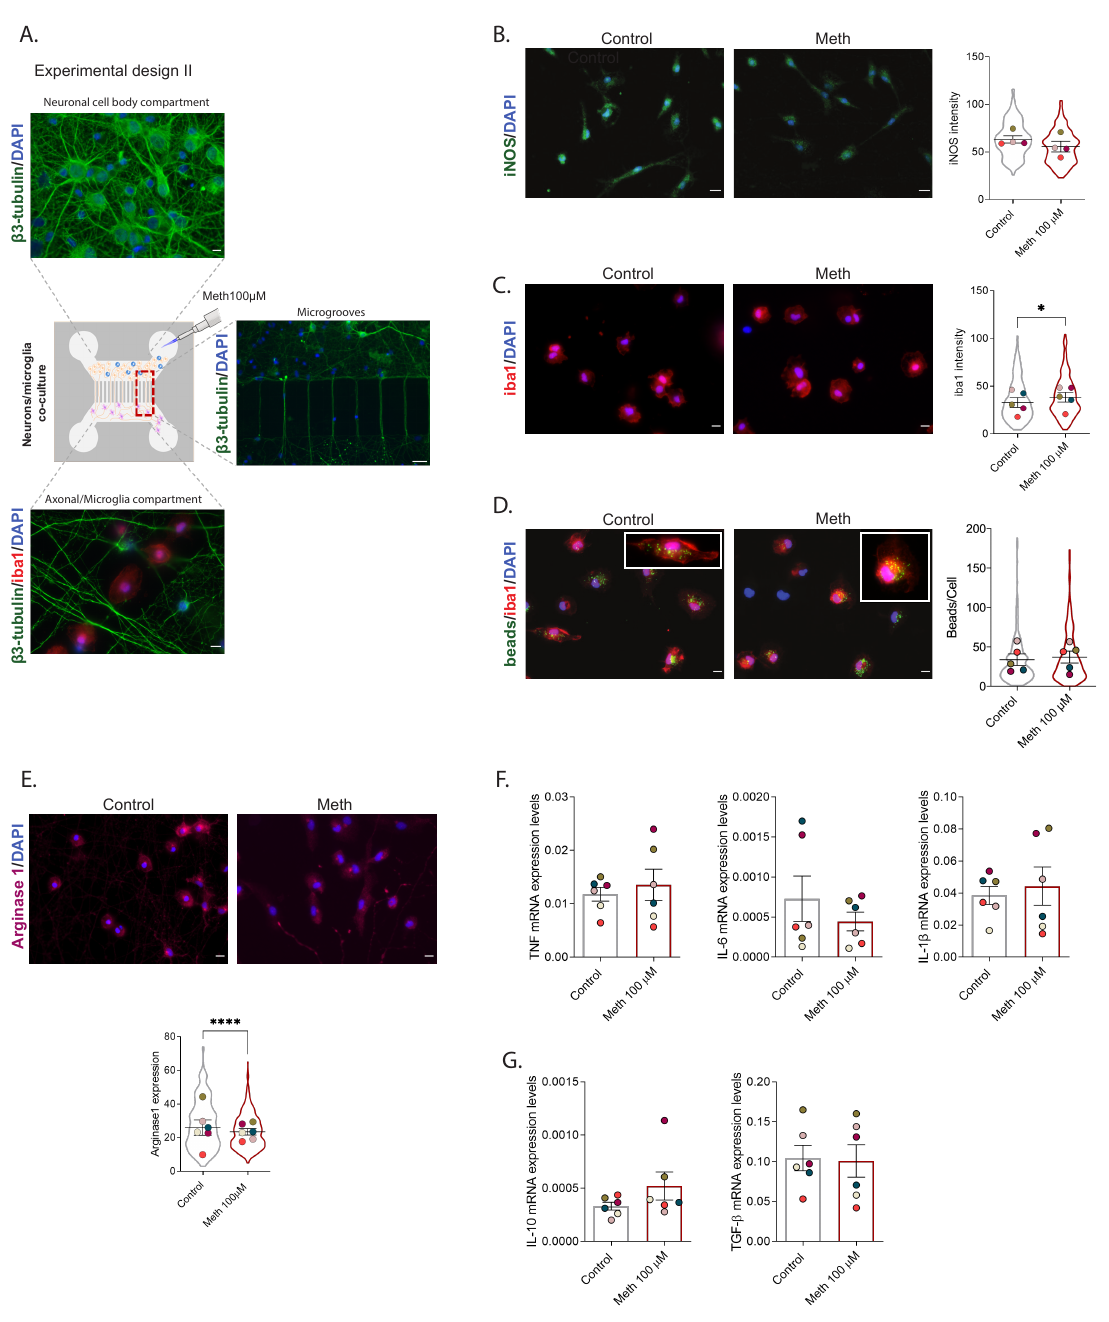
Figure 2. Neurons exposed to Meth and in direct contact with microglia do not promote its activation. ( A ) Experimental design II—neuronal cell culture from the hippocampus was seeded in one side of a microfluidic device, and the axons were allowed to extend to the other compartment for 12 days.